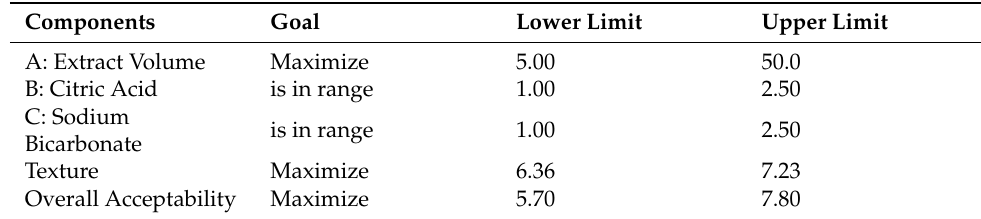
Table 3. Components and optimization